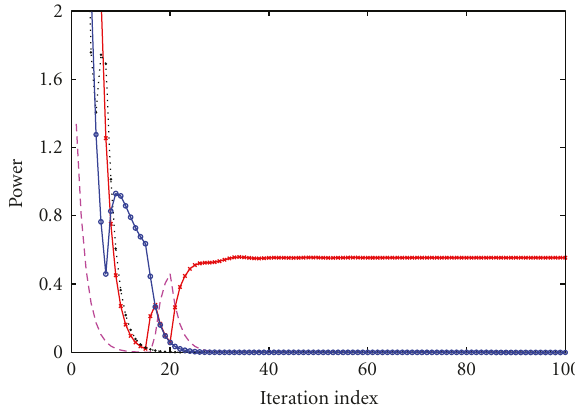
Figure 5: Illustration of P l ( i ) ( k ) of the DCLS algorithm with K = 4 for the square network of 72 links versus the iteration index i , for an arbitrary l and all k = 1,2,3,4, where λ = 35 and ξ = 0 . 6. At convergence, only one of P l ( i ) ( k ) for k = 1,2,3,4 is